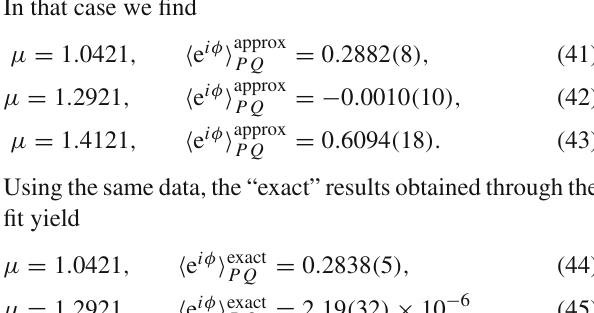
Fig. 5 Relative difference (in percentage) on the phase factor expecta- tion value between the telegraphic approximation (35) and the “exact” answer [16]. Not visible in the plot is the point μ = 1 . 4121, for which the relative error is 0 .